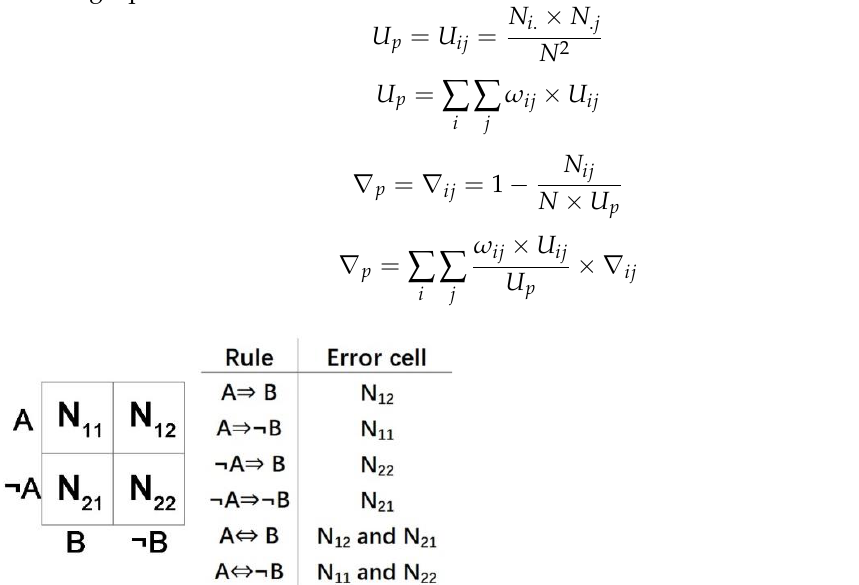
Figure 6. Contingency table of the Boolean implication rule and their corresponding error cells in prediction logic.